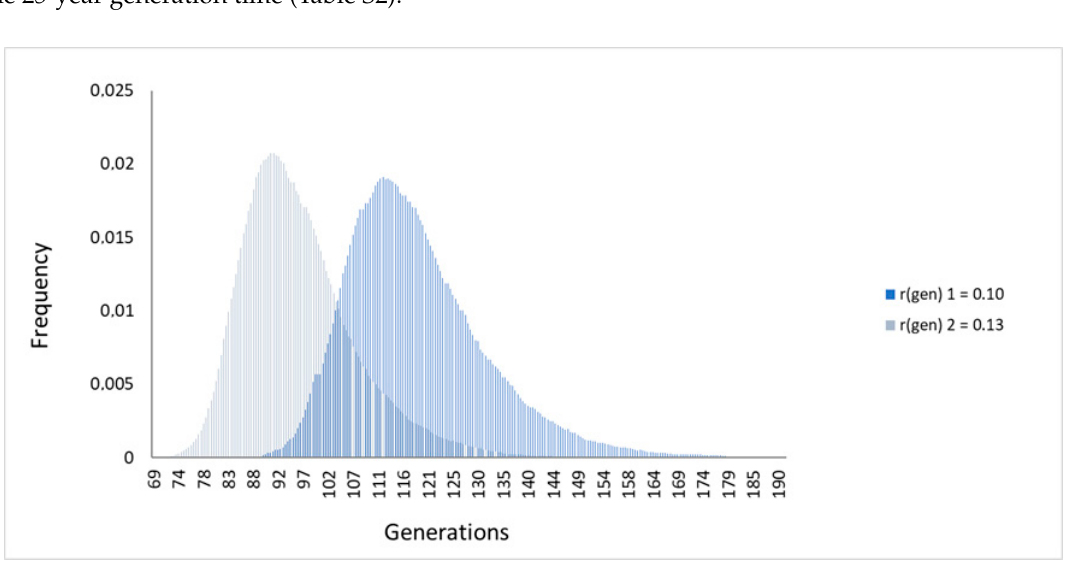
Figure 3. Possible geographic dispersal scenario inferred from present data of the populations carrying CHEK2 variant c.349A>G, with the average age estimates obtained by DMLE+2.3, using the